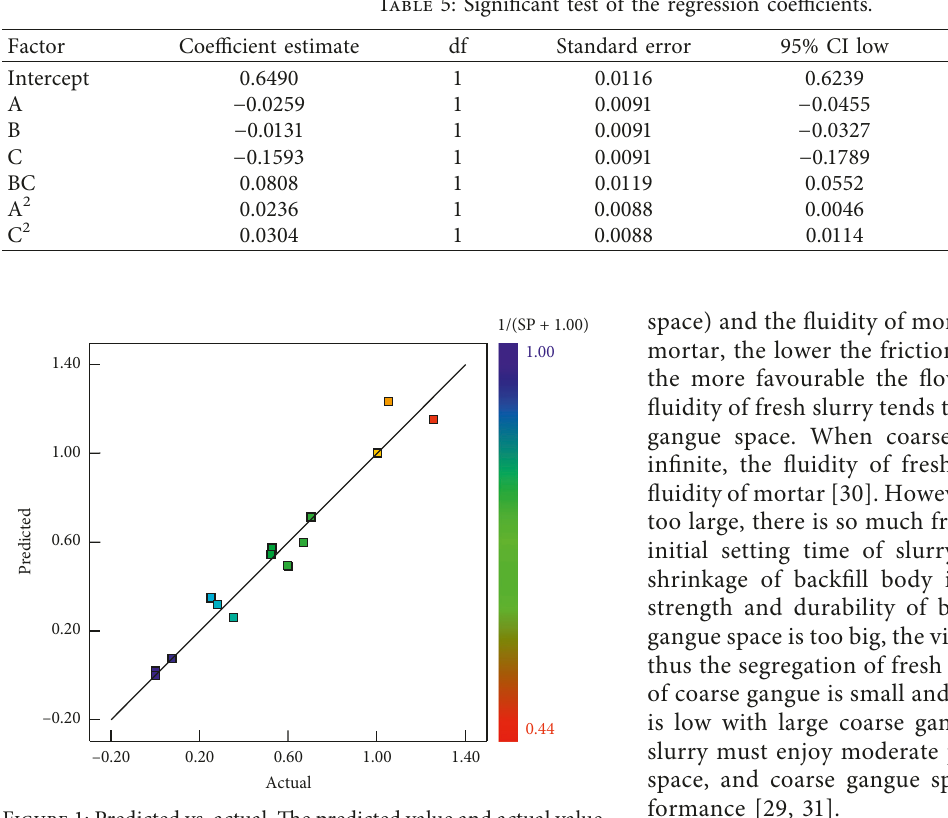
Figure 1: Predicted vs. actual. The predicted value and actual value are mainly in a straight